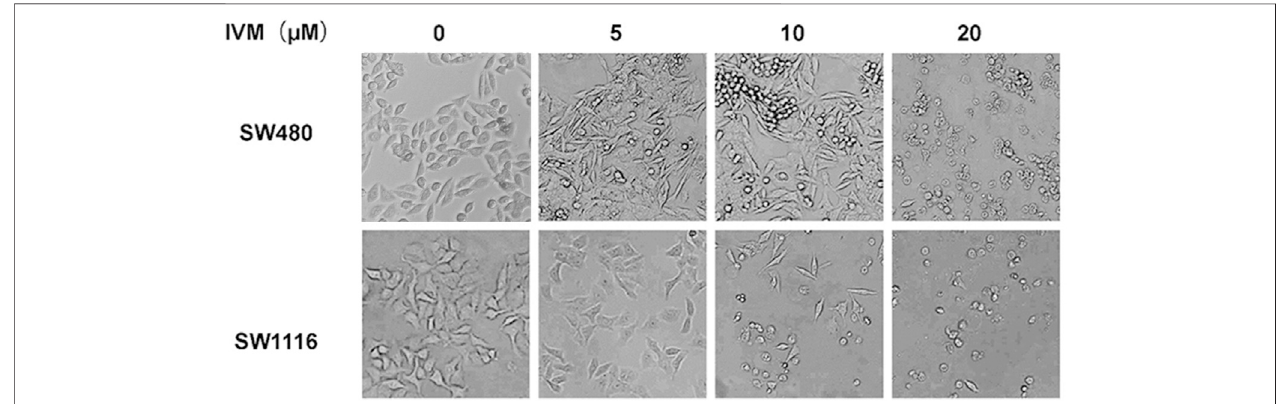
FIGURE 3 | The effect of ivermectin on the morphology of colorectal cancer cells SW480 and SW1116 cells. Colorectal cancer SW480 (A) and SW1116 (B) cells weretreatedwithdifferentconcentrationsofivermectin(0,5,10,and20 μ M)for24 h,andthenthecellmorphologywasdeterminedusinganopticalmicroscope(200 × ). This experiment was repeated three times, and representative images were shown. IVM, ivermectin.